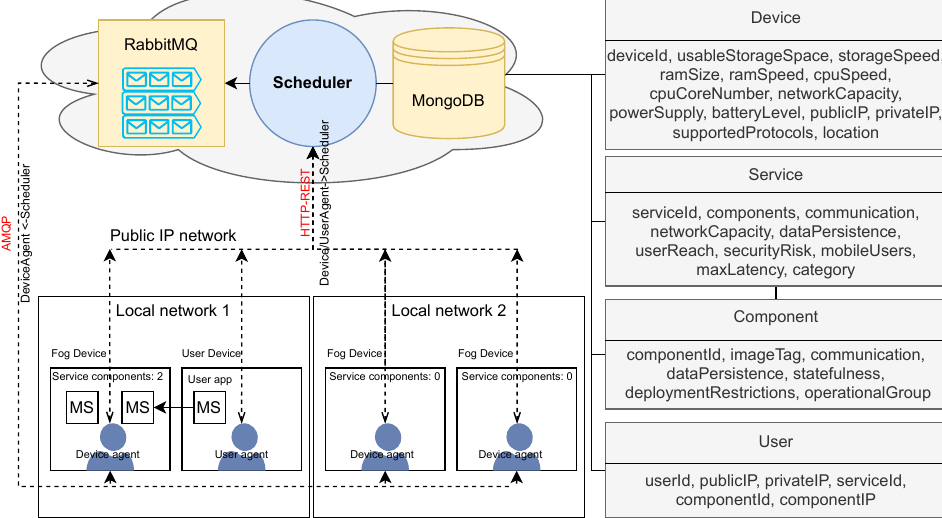
Figure 4. System architecture and the utilized data